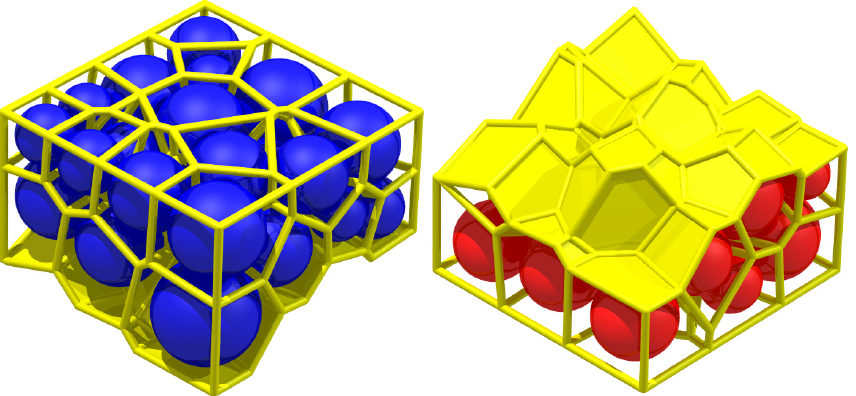
Figure 10. The face set which characterizes a macro contact of granular material.